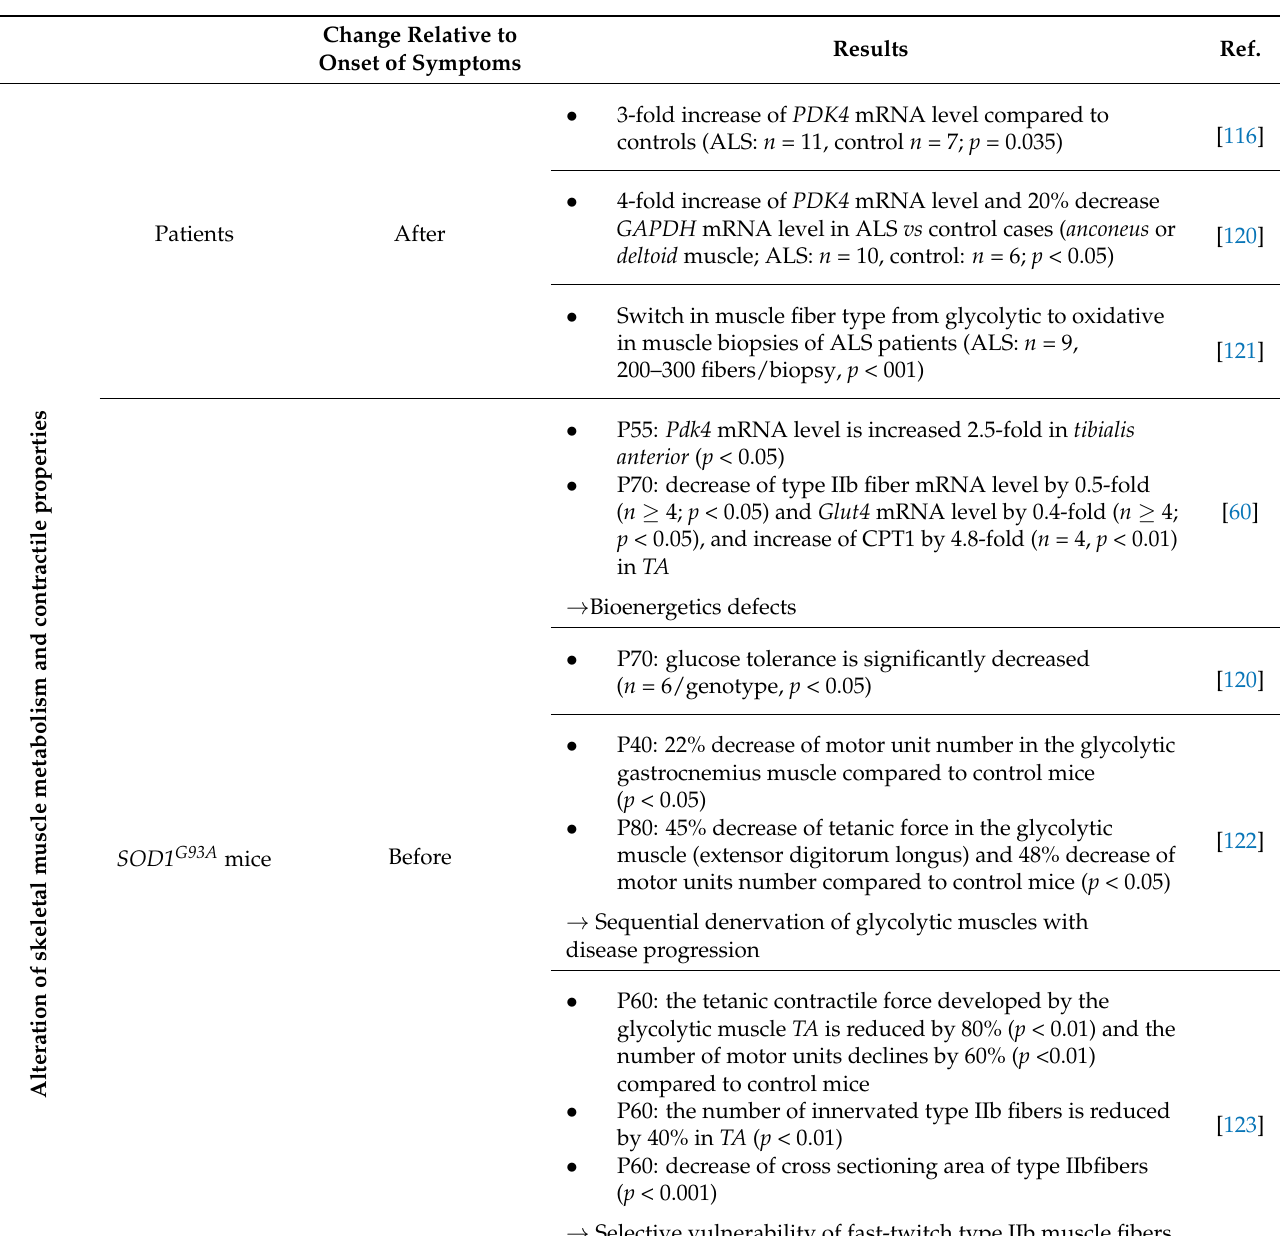
Table 3. Summary of the main alterations of metabolism and contractile properties of skeletal muscle in ALS patients and ALS mouse